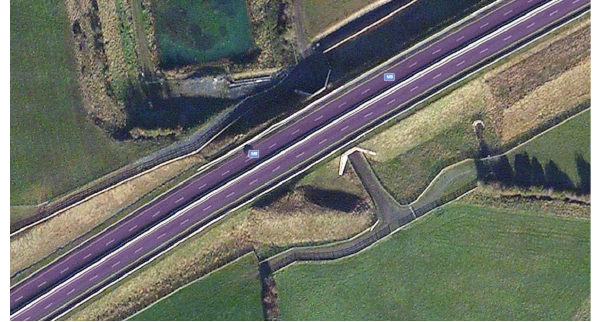
Figure 3: Bridge location (Microsoft Bing Maps)